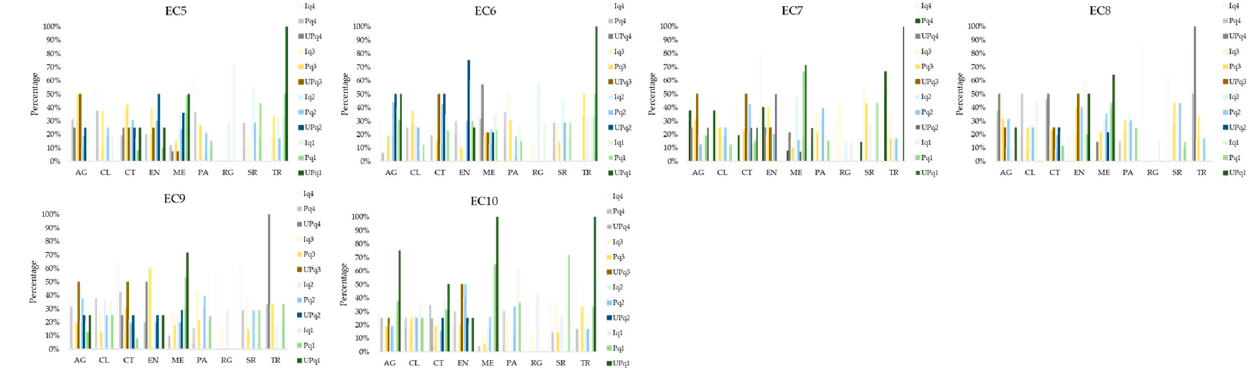
Figure A1. Comparison of the percentages of municipalities for different metropolitan cities in Sicily based on the quartiles of indicators for economic capital, and the NSIA classification. (Authors’ elaboration).